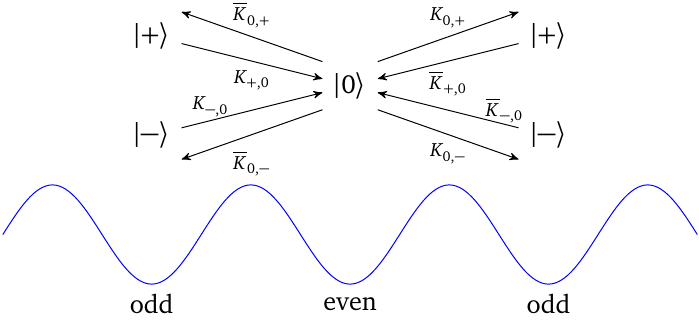
Figure 7: The four kinks and anti-kinks in supersymmetric sine-Gordon theory. Kinks go from left to right, anti-kinks from right to